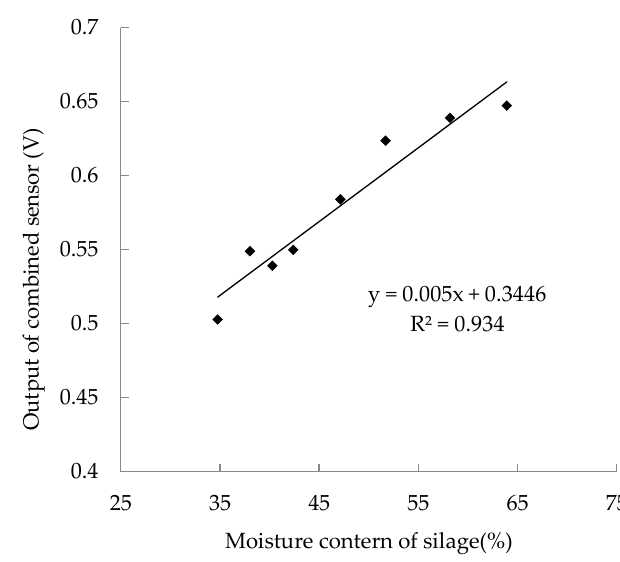
Figure 7. The calibration of moisture content results.